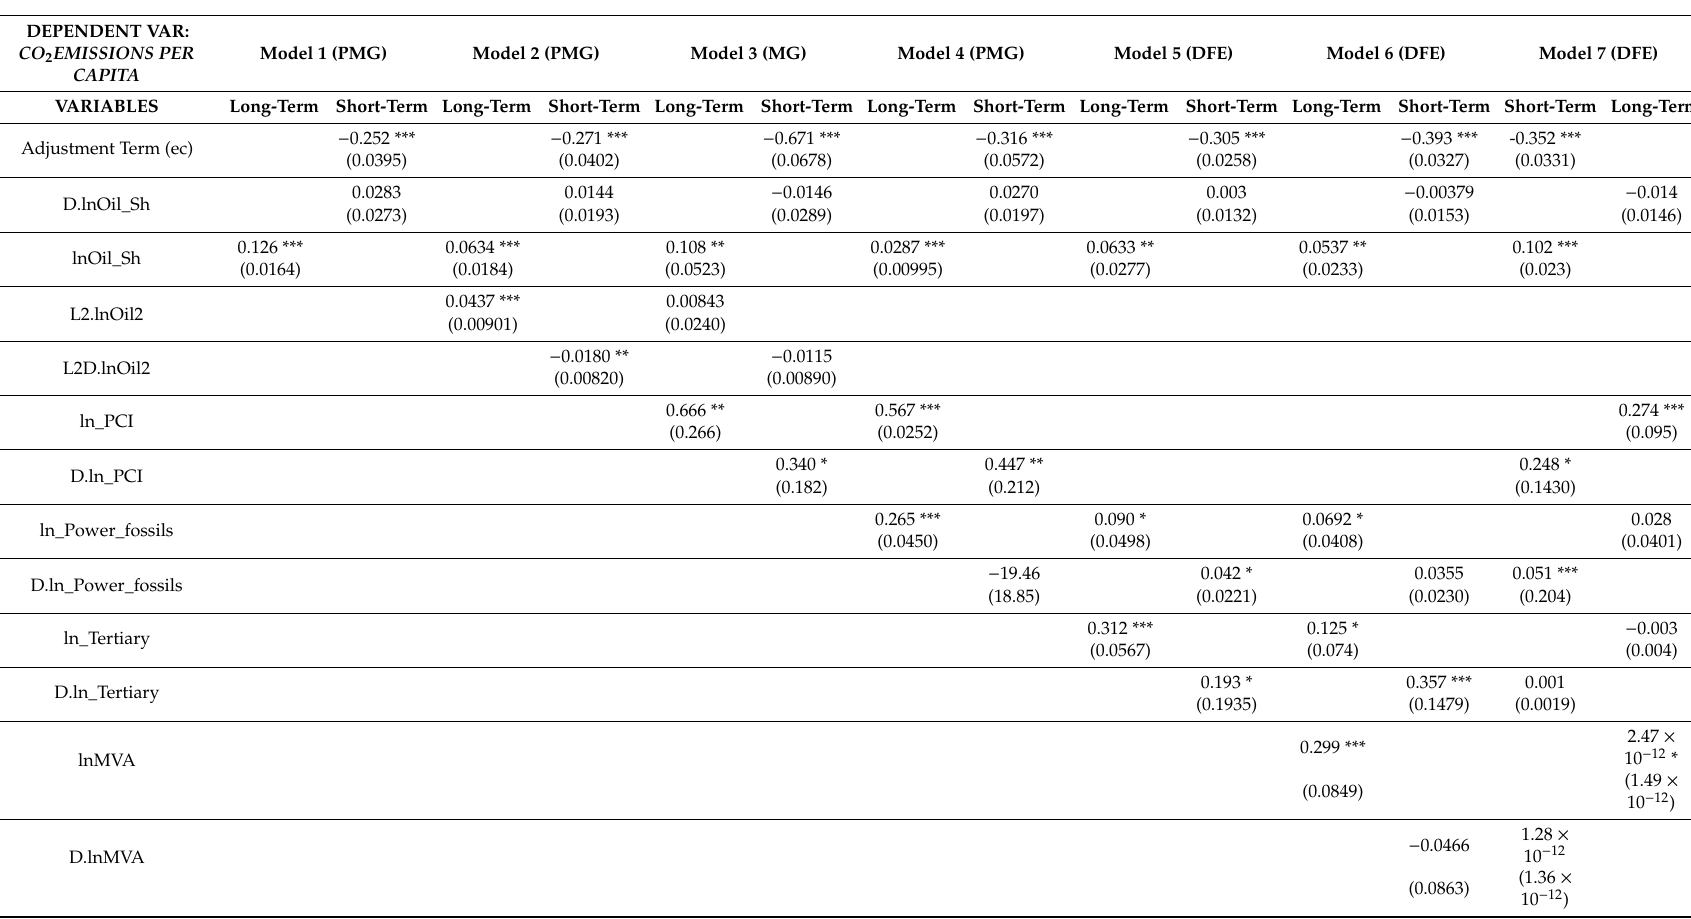
Table 2. Panel Cointegration Estimators,